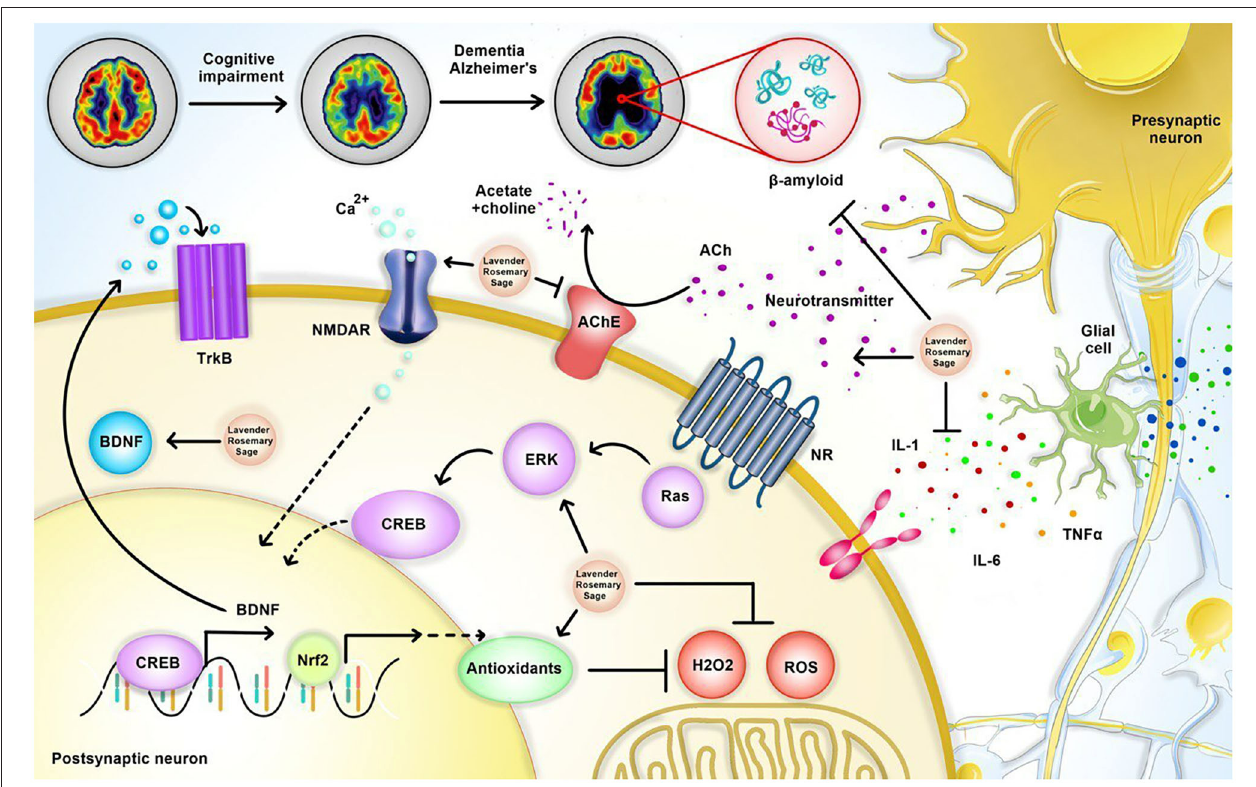
Figure 1 | Neuroprotective effects of sage, lavender, and rosemary in neurological disorders. Sage, lavender, and rosemary exert neuroprotective effects mainly through increasing neurotransmitters and antioxidants, activating ERK/CREB/BDNF pathway, and inhibition of β -amyloid, pro-inflammatory cytokines, and Acetylcholine esterase (AChE) activity. BDNF, brain-derived neurotrophic factor; CREB, cyclic AMP response element-binding protein; NR, neurotransmitters receptor; ERK, extracellular signal-related kinase; TNF, tumor necrosis factor; TrkB, BDNF/NT-3